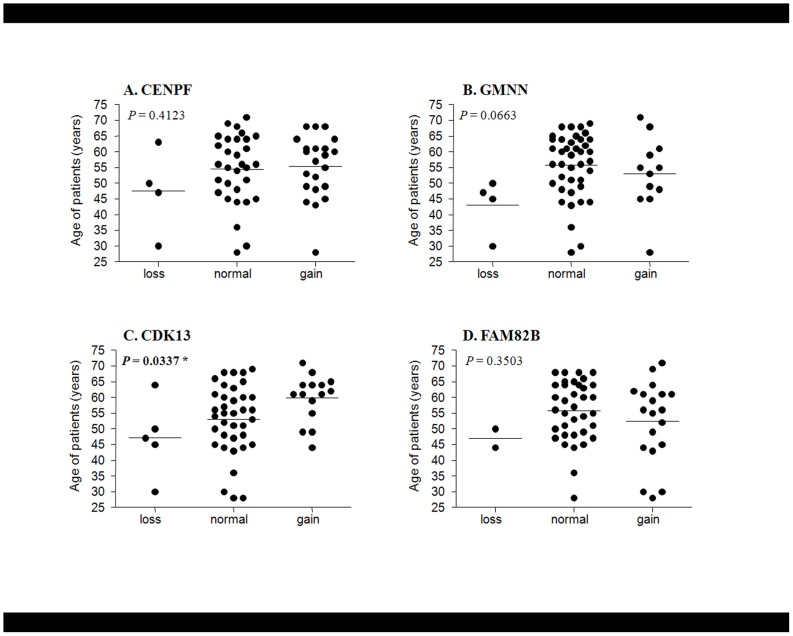
Association of CDK13 gene amplification with clinical onset of cancer in HCC patients.Mean age of clinical onset is indicated by horizontal bars. The statistical significance of differences was determined by ANOVA.